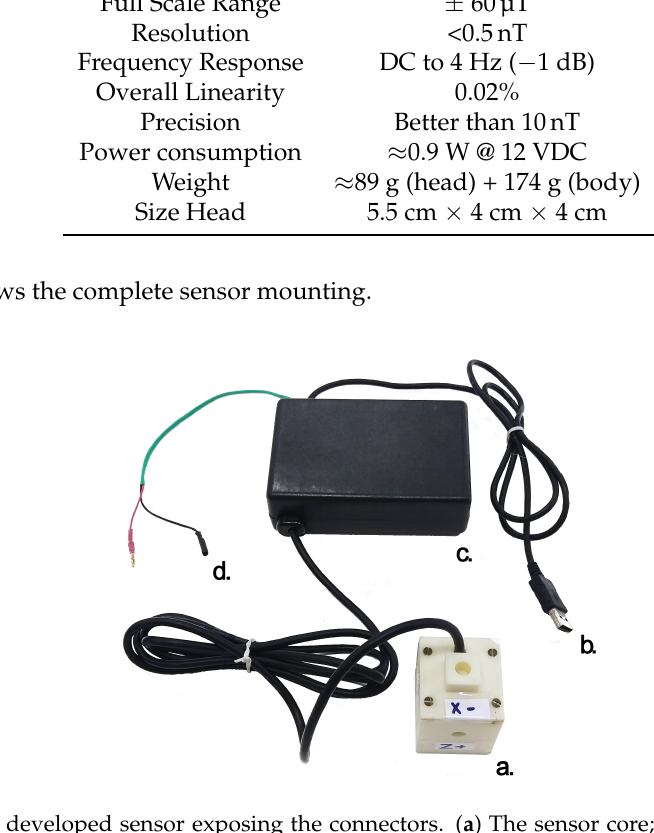
Figure 1. The developed sensor exposing the connectors. ( a ) The sensor core; ( b ) serial connector to acquire the data; ( c ) the Printed Circuit Board (PCB) protected by a small plastic case; and ( d ) power